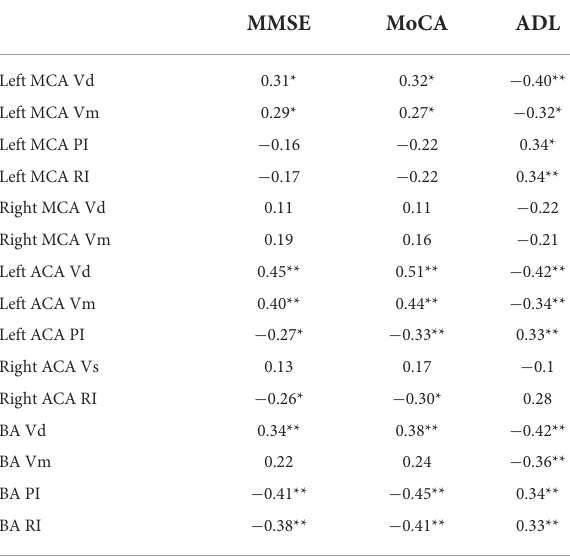
TABLE 5 Pearson’s correlations between TCD parameters and neuropsychological